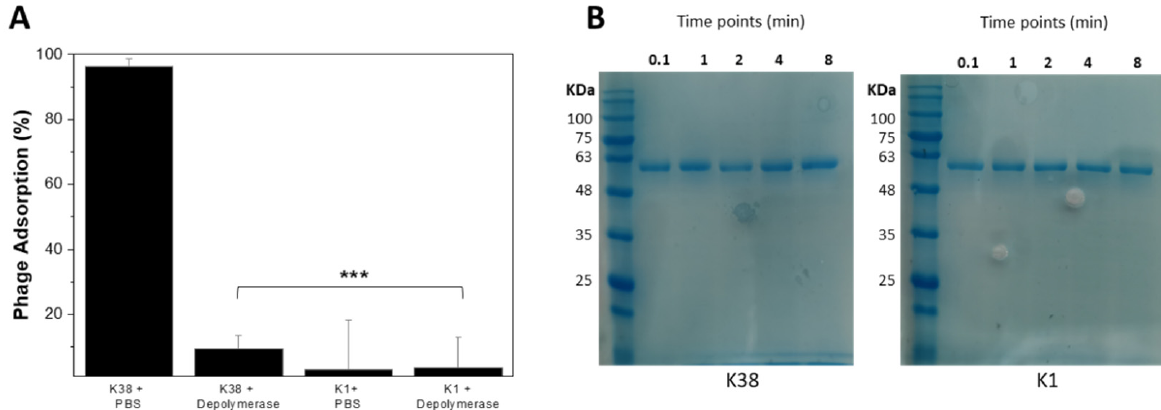
Figure 3. Tailspike interaction with capsules. ( A ) Adsorption rate of phage 3043-K38 particles in K38 host cells pre-treated with PBS (control) or K38 depolymerase at 1 µM (test), obtained by subtracting the titre before (total phage titre) and after centrifugation (non-adsorbed phage titre). Error bars represent standard deviation for three repeated experiments. Statistical significance was determined by Student’s t -test (***, p < 0.001). ( B ) Binding of the K38 depolymerase to K38 cells assayed as described in the material and methods. In brief, recombinant K38 depolymerase was incubated with K38 (sensitive to the enzyme) or K1 cells (not sensitive to the enzyme) at different time points (0.1, 1, 2, 4, 8 min). Immediately afterward, samples were centrifuged, and the supernatant was collected and loaded in a 12% SDS-PAGE gel.